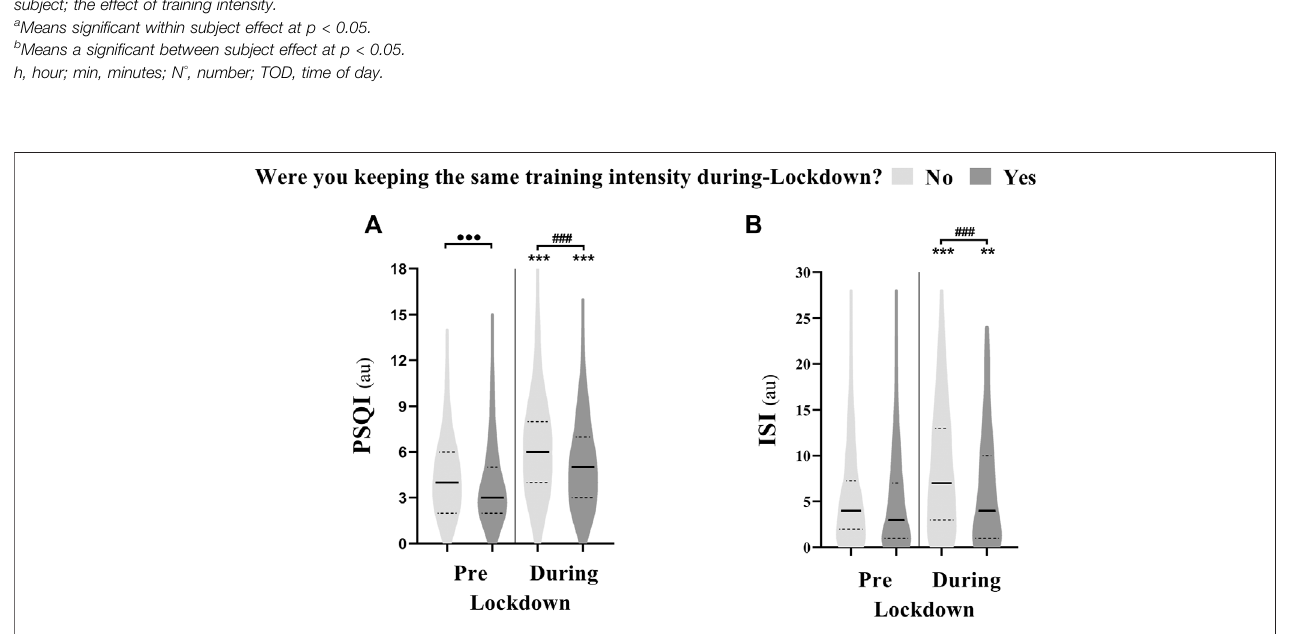
FIGURE 2 | Violin plot showing the difference in (A) Pittsburgh sleep quality index (PSQI) and (B) insomnia severity index (ISI) between athletes who were keeping the same training intensity during-compared to pre-lockdown ( n = 351; Yes) and those who were not ( n = 1,025; No). *** means signi fi cant within subject effect of the lockdown at p < 0.001. ··· means signi fi cant between subject effect pre-lockdown at p < 0.001. ### means signi fi cant between subject effect during-lockdown at p < 0.001. Signi fi cance is assessed by a mixed design ANOVA and the Bonferroni post-hoc test.